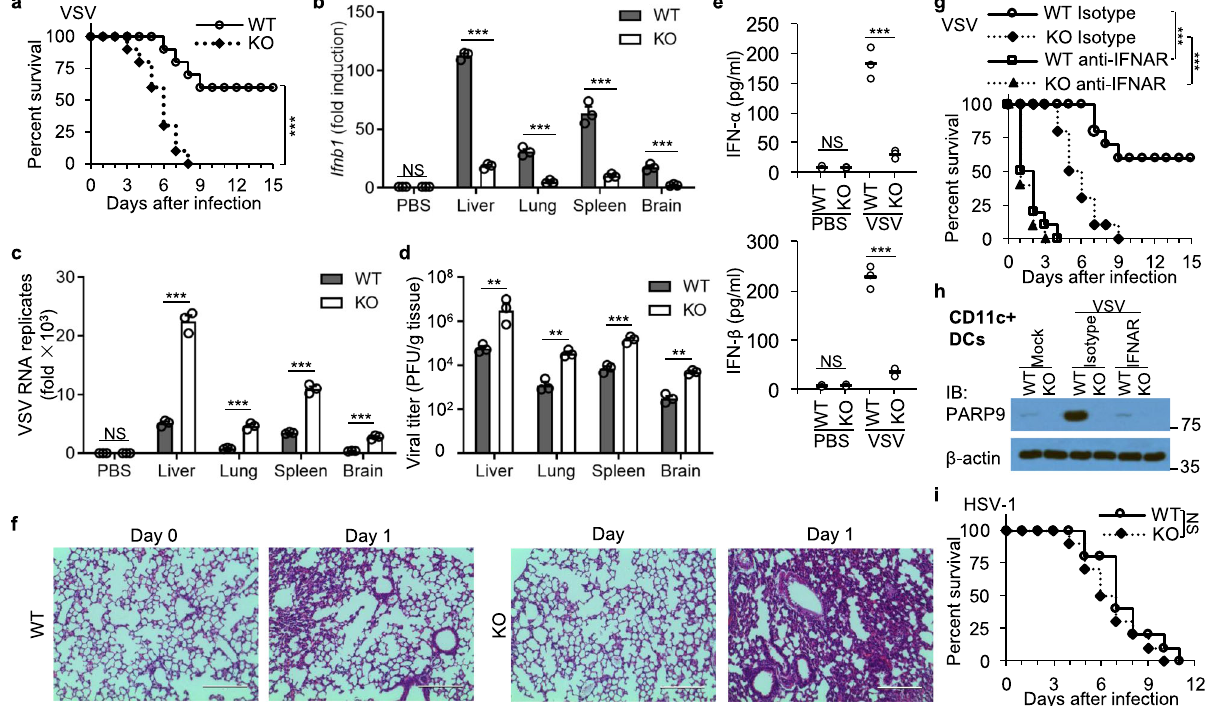
Fig. 3 PARP9 plays a critical role in host defense against RNA virus infection in vivo. a Survival of age- and sex-matched PARP9 + / + (WT) and PARP9 − / − (KO) mice after intraperitoneal infection with VSV (5 × 10 8 PFU per mouse) ( n = 10 per group). b The qRT-PCR analysis of Ifnb1 mRNA in the liver, lung, spleen, and brain of PARP9 + / + (WT) and PARP9 − / − (KO) mice (three per group) infected for 24 h by intraperitoneal injection of phosphate-buffered saline (PBS) or VSV (5 × 10 7 PFU per mouse); results are presented relative to those of untreated wild-type cells ( n = 3 per group). c The qRT-PCR analysis of VSV RNA in the liver, lung, spleen, and brain of mice as in b ; results are presented as in b ( n = 3 per group). d Plaque assay of VSV titers in the liver, lung, spleen, and brain of mice as in b ( n = 3 per group). e ELISA of IFN- β and IFN- α in sera from mice as in b ( n = 3 per group). Each circle represents an individual independent experiment and small solid black lines indicate the average of triplicates. f Hematoxylin and eosin (H&E)-staining of lung sections from mice as in b . Scale bars represent 200 μ m. g Survival of age- and sex-matched PARP9 + / + (WT) and PARP9 − / − (KO) mice after intraperitoneal infection with VSV (5 × 10 8 PFU per mouse) treated with 500 μ g anti-IFNAR antibody or isotype control antibody starting 1 day before infection, followed by 250 μ g three times per week for up to 2 weeks ( n = 10 per group). h Immunoblot analysis of PARP9 expression in mouse CD11c + splenic DCs from WT and PARP9 KO mice treated as in g for 1 day. i Survival of age- and sex-matched PARP9 + / + (WT) and PARP9 − / − (KO) mice after intravenous infection with HSV-1 (1 × 10 7 PFU per mouse) ( n = 10 per group). Error bars indicate standard error of the mean for results in c , d . NS, not signi fi cant ( p > 0.05), ** p < 0.01, *** p < 0.001, **** p < 0.0001, and p value was calculated by unpaired two-tailed Student ’ s t test and Gehan – Breslow – Wilcoxon test for survival analysis. Data are representative of three independent experiments. Exact p values ( a , p = 0.0004; b , p = 1, p < 0.00001, p = 0.00034, p = 0.00068, p = 0.00082; c p = 1, p = 0.00009, p = 0.00007, p = 0.00028, p = 0.00028; d , p = 0.0082, p = 0.0014, p = 0.00064, p = 0.0013; e upper, p = 0.84, p